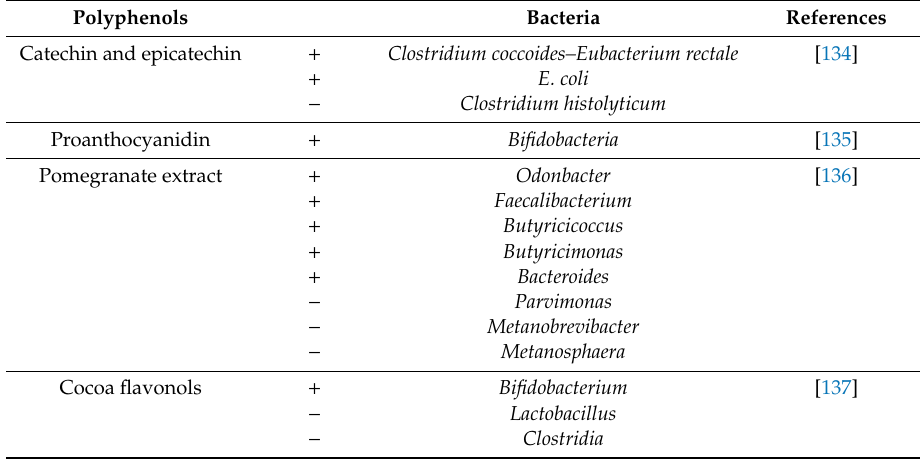
Table 3. Summary of the main findings of clinical trial studies related to the e ff ects of polyphenols on gut microbiota by increase ( + ) or decrease ( − ) of specific